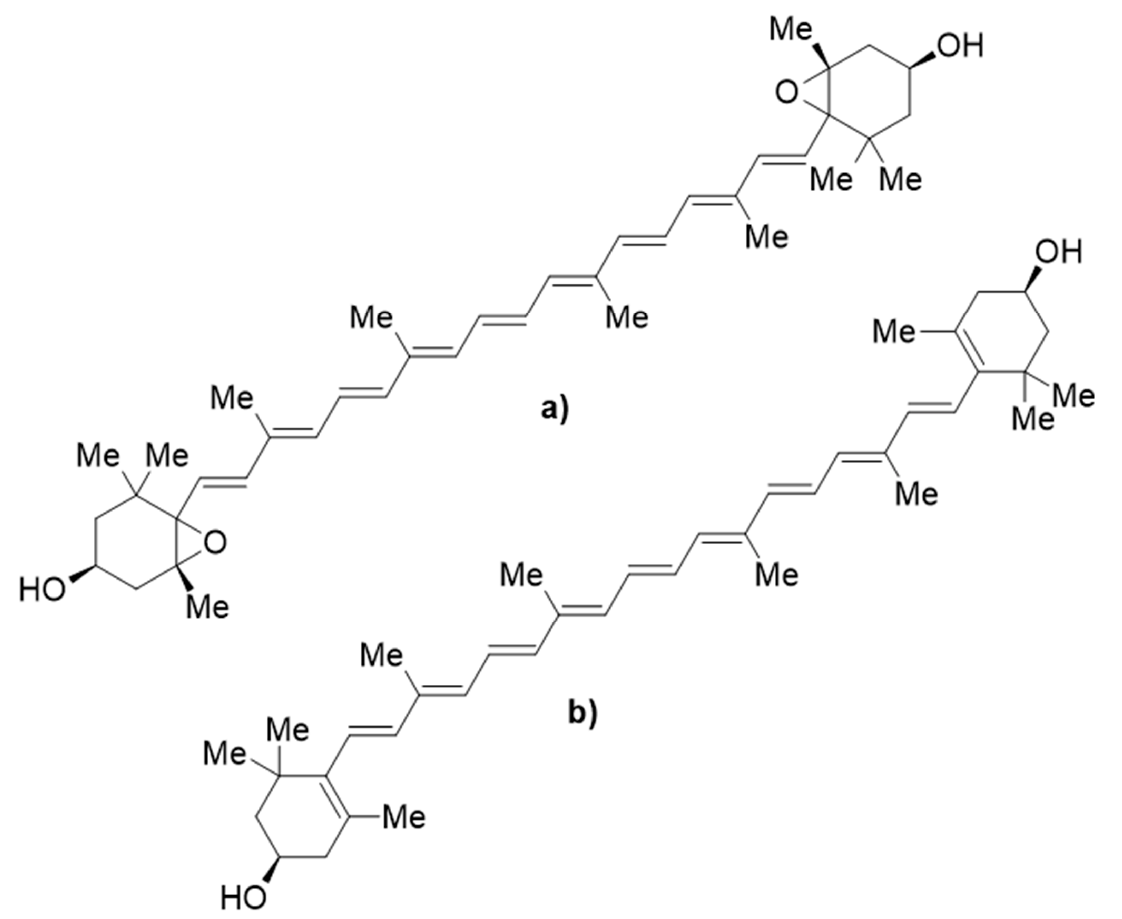
Figure 4. The chemical structures of ( a ) violaxanthin and ( b ) zeaxanthin.